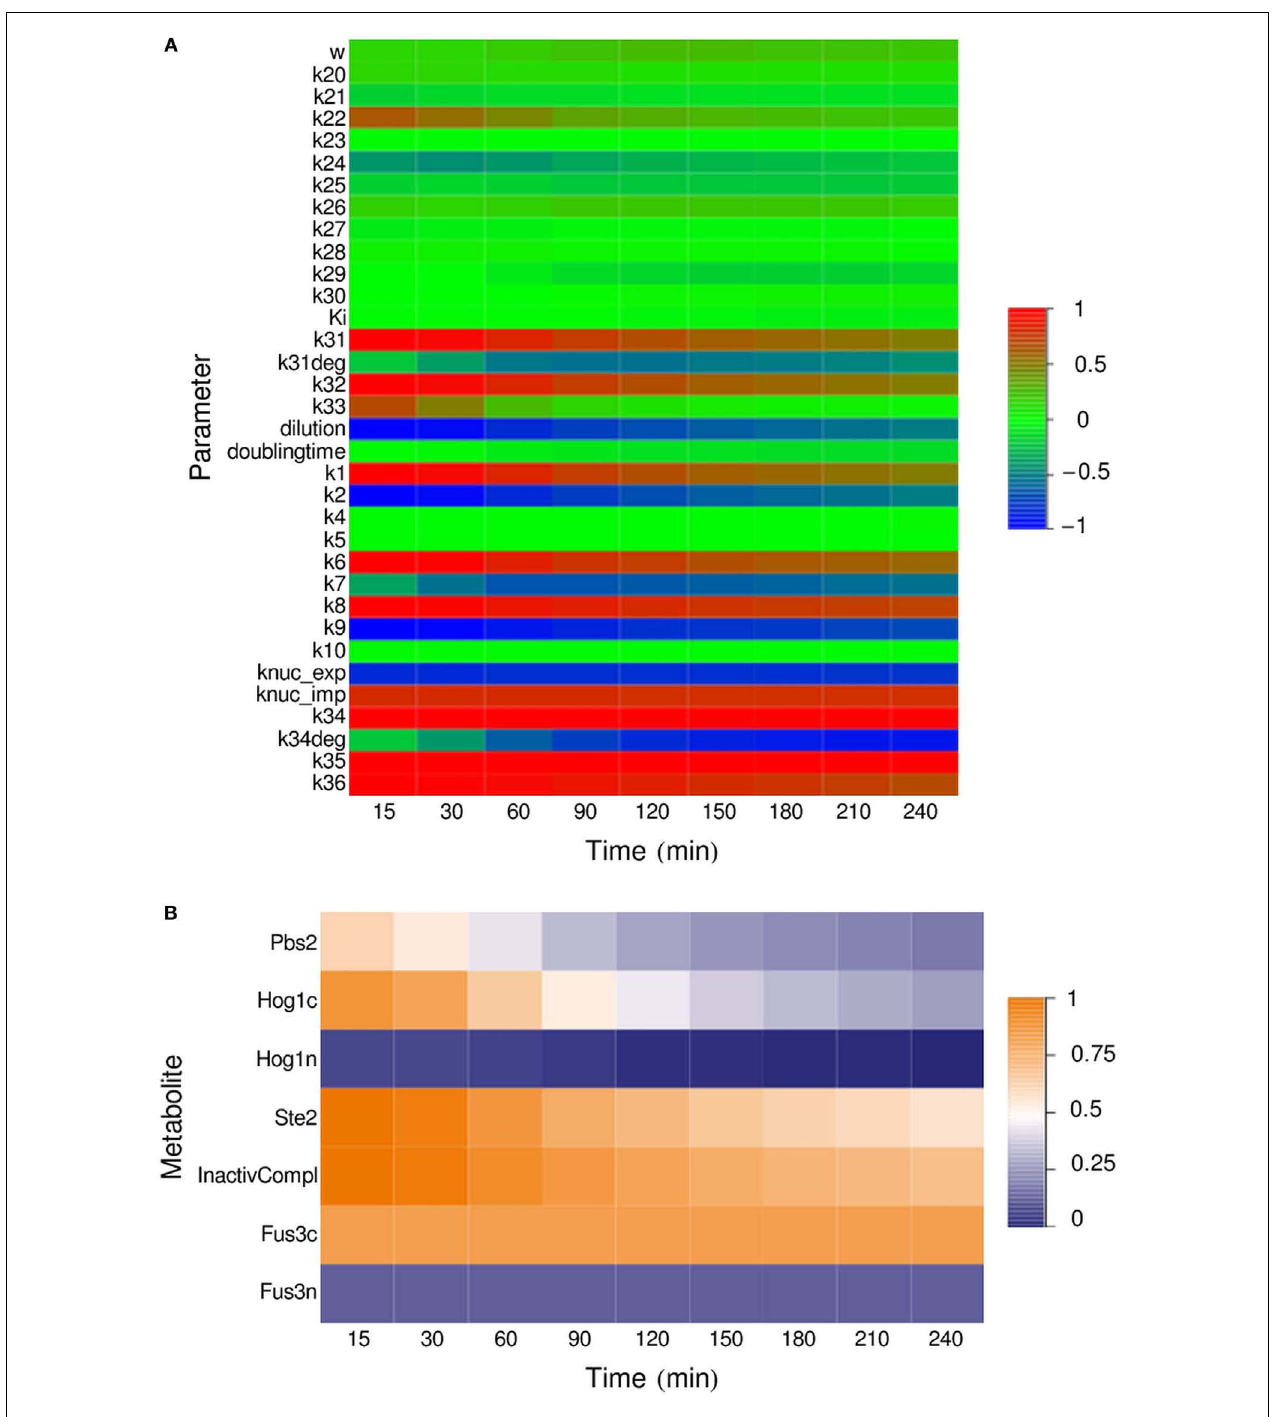
were varied and their relative influence on system output at the indicated time points was determined (for details, see Materials and